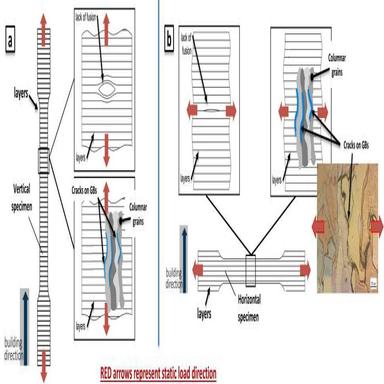
Schematic of (a) Vertical specimen and (b) Horizontal specimen behaviour during tensile static test.